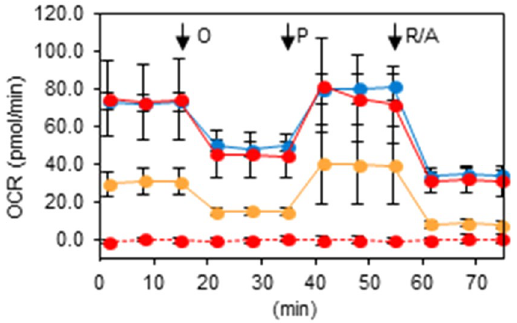
Figure 1. Mitochondrial oxygen consumption rates in Nthy-ori 3-1, XTC.UC1, TPC1 and TPC1 ρ0 cells. The oxygen consumption rates were measured at the basal levels and after 2 μM oligomycin (O), 0.25 μM phenylhydrazone (P) and 0.5 μM rotenone/antimycin (R/A) treatments as described in the “Materials and methods”. Blue, Nthy-ori 3-1; yellow, XTC.UC1; red with solid lines, TPC1; red with broken lines, TPC1 ρ0 cells. Data are presented as means ±